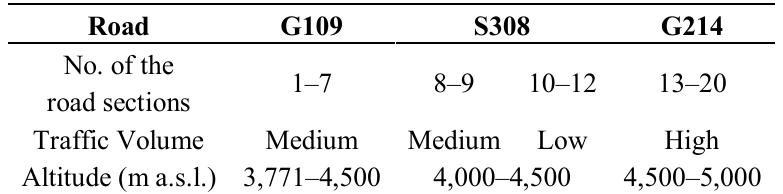
Table 1. Sampling section